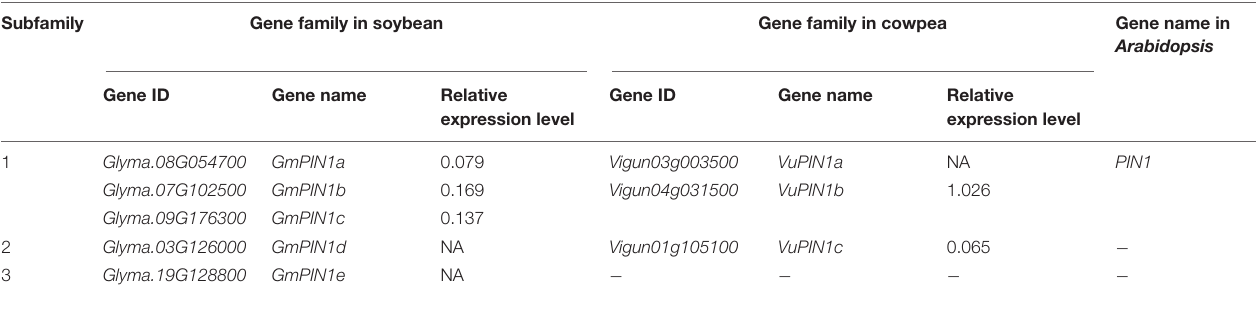
TABLE 1 | Homologous genes of PIN1 gene family in soybean, cowpea, and Arabidopsis thaliana . Subfamily Gene family in soybean Gene family in cowpea Gene